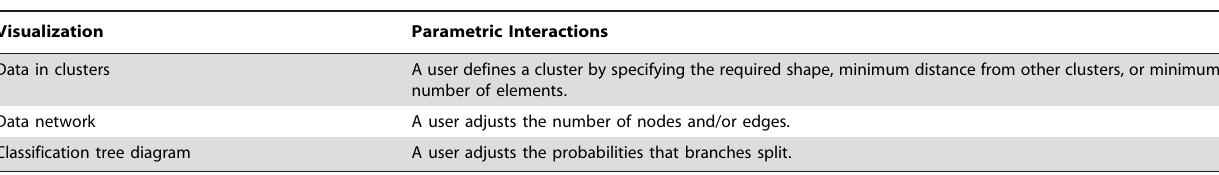
Table 1. A non-exhaustive list of parametric interactions.